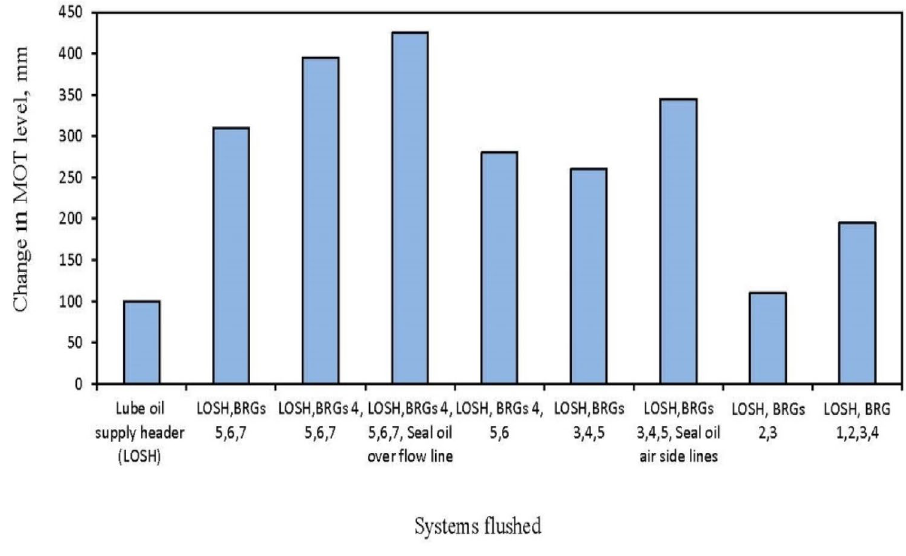
Fig. 6 Change in level of MOT vs system flushed